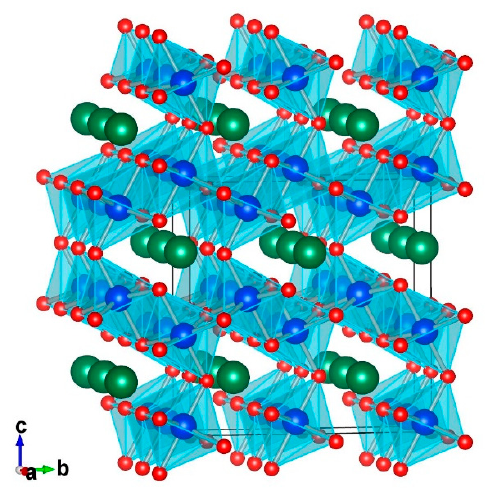
Figure 5. Crystal structure of CaTi 2 O 4 -type AB 2 O 4 . Small red spheres, middle blue ones and large green ones express oxygen, B and A cations, respectively. The structure was drawn by VESTA [41]. Sp-type titanomagnetites were found as inclusions in diamonds from some localities in Juina,